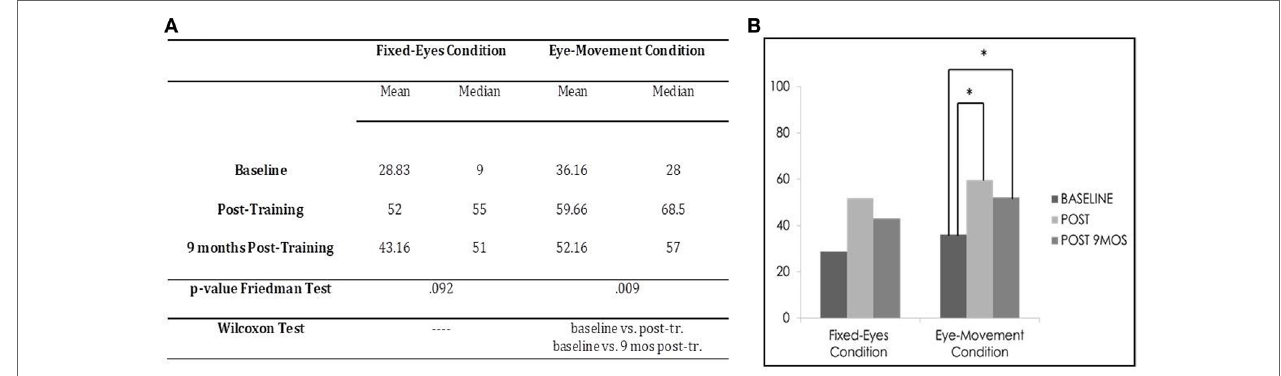
FIgUre 6 | Subject 3: unimodal visual test. (A) Mean and median percentages of visual detections (hemianopic hemifield) in the different evaluations, p -value of the Friedman Tests and results of Wilcoxon Tests. (B) Graphical Representation: mean percentages of visual detections ( y -axis) at baseline vs. post-training vs. 9 months post-training ( x -axis).